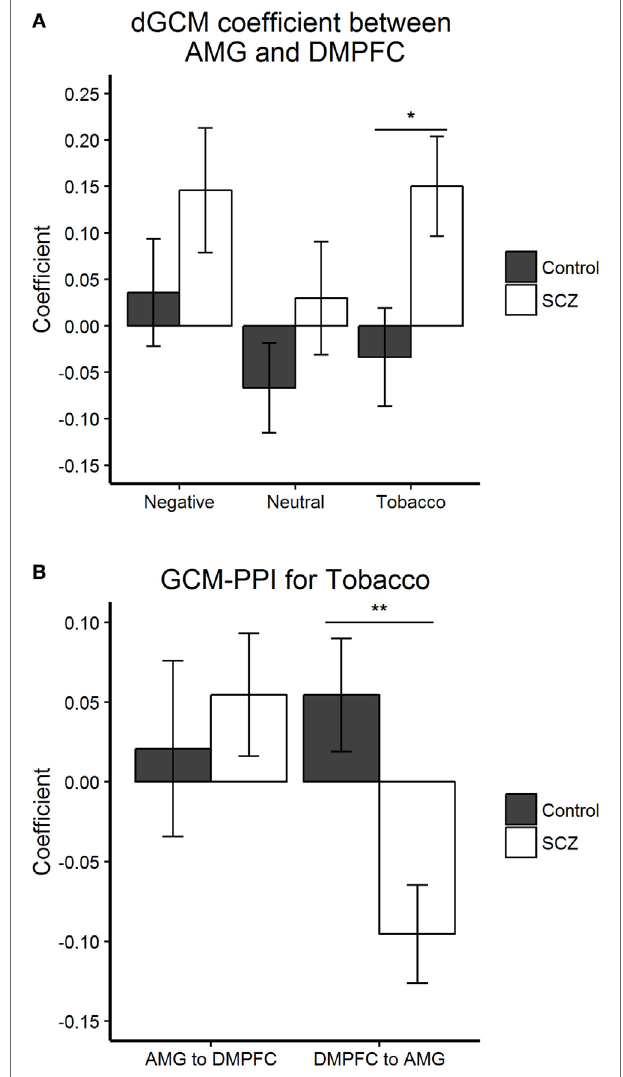
FigUre 3 | Granger-causal connectivity: group differences within each condition. (a,B) Bar plots display the mean and SEM. (a) Condition-by- condition analysis revealed a significant dGCM (A to B minus B to A) ( F 1,42 = 5.962, * p = 0.019) group difference during aversive smoking-related stimuli (Tobacco) for the connectivity between left AMG and dmPFC. (B) The autoregressive Granger causality modeling (GCM)- psychophysiological interaction (PPI) components underlying dGCM allowed to investigate the lagged connectivity from the AMG to DMPFC and from DMPFC to AMG separately, during the Tobacco condition. The latter revealed a significant ( F 1,42 = 10.039, ** p = 0.003) between-group difference in lagged connectivity from the DMPFC to the AMG during viewing of aversive smoking-related stimuli (Tobacco). Abbreviations: AMG, left amygdala; DMPFC, dorsomedial prefrontal cortex; SCZ, schizophrenia patients; Control = healthy control